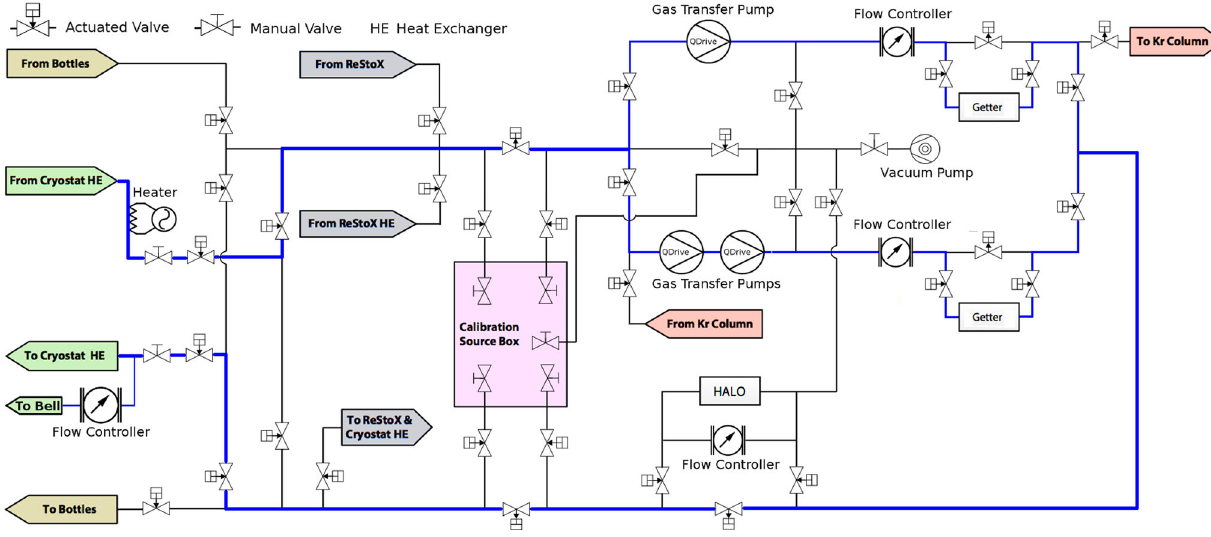
Fig. 8 Piping and instrumentation diagram (P&ID) of the XENON1T purification system. The system also serves as the main interface to the other components of the gas-handling system (see Fig. 9) and allows the insertion of short-lived isotopes for calibration. Some instrumenta-